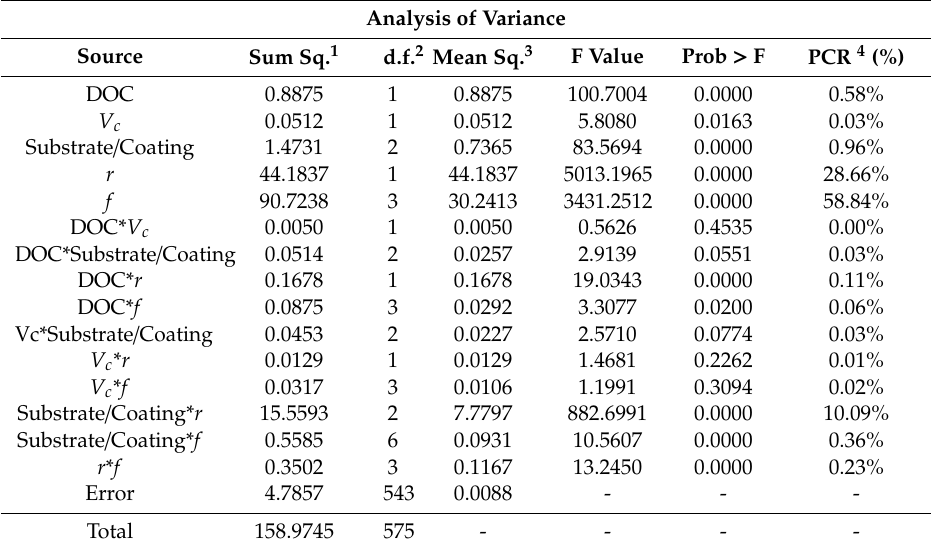
Table 3. Standard five-way ANOVA table results for Ra applying two-factor interactions model. Analysis of Variance